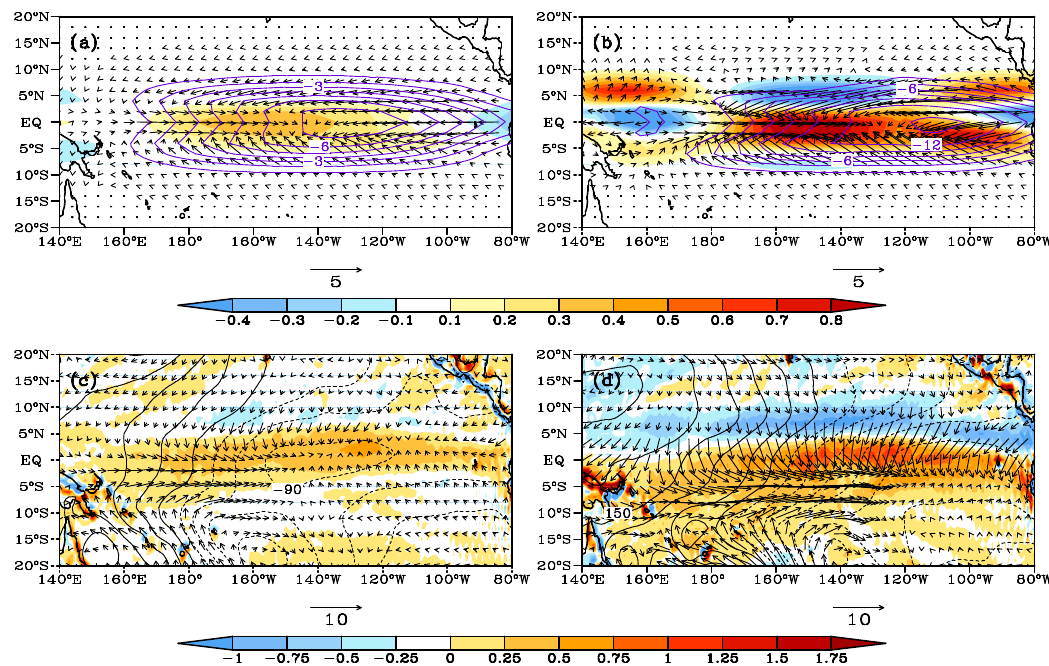
Figure 9. Comparison of the responses of the atmospheric wind field (vector, unit: m/s), pressure (contour line, unit: gpm), and vertical velocity (shade, unit: 10 −2 m/s) to the heat source distribution of two types of El Niño ( a is CP-El Niño, and b is EP-El Niño), with the actual atmospheric anomalies ( c is CP-El Niño, and d is EP-El Niño). The continents in Figure (a) and Figure (b) are shown just for geographical reference.